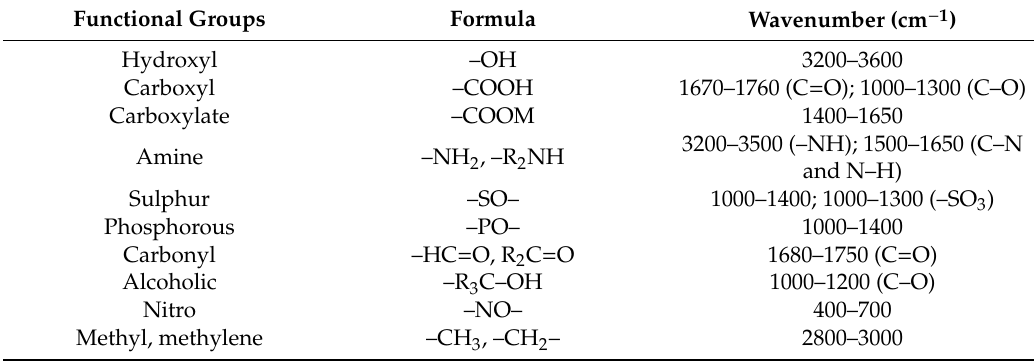
Table 1. Vibrational stretches of functional groups related to biosorption [45].